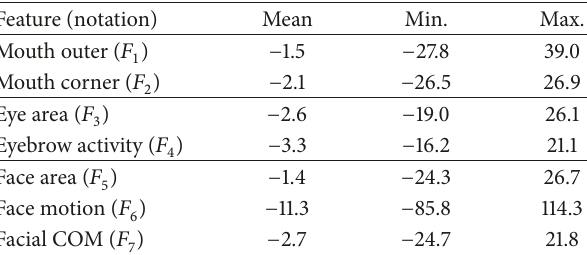
Table 5: Percentage of change of features from period 𝐻 0 to 𝐻 1 in the Tetris game ( 𝑁 = 20